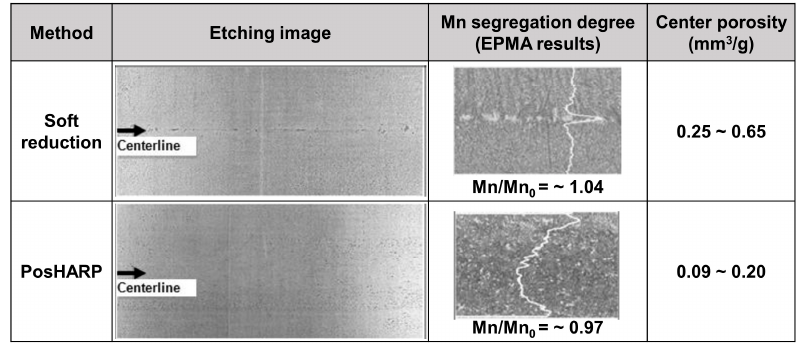
Figure 27. Effects of SEMS with soft reduction on segregation and porosity defects [43]. Figure 27. E ff ects of SEMS with soft reduction on segregation and porosity defects [43].